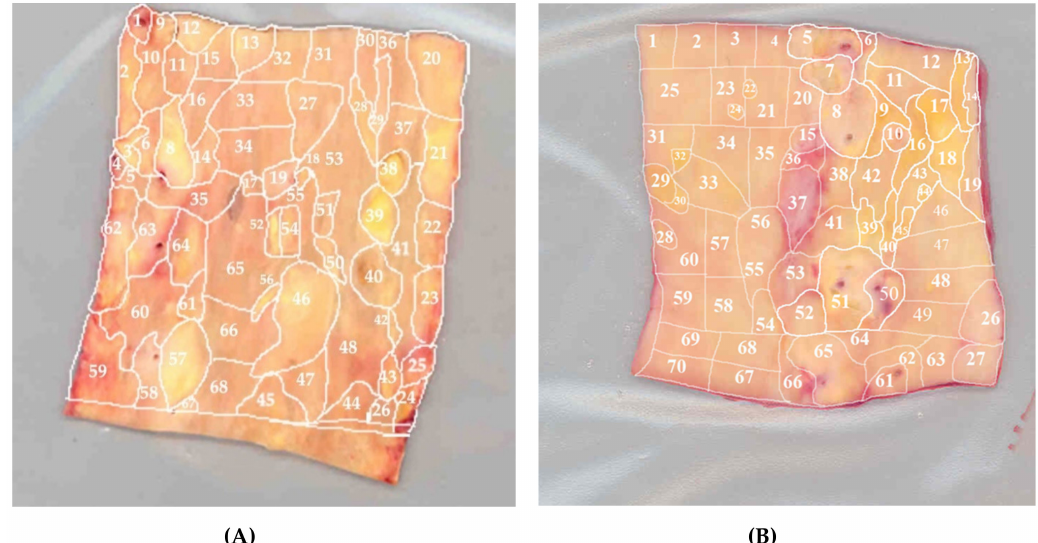
Figure 7. Morphological mapping of the aorta samples. Presented are two examples of morphological mapping of the aortic wall: ( A ) and ( B ). Segments of the vascular wall were divided according to morphological characteristics into 68 ( A ) and 70 ( B ) regions containing atherosclerotic lesions of varying severity (fatty infiltration, fatty streak, lipofibrous plaque, fibrous plaque) or una ff ected tissue. These and other aorta samples were further analyzed for the mutational burden in mtDNA. Adapted from [119] with